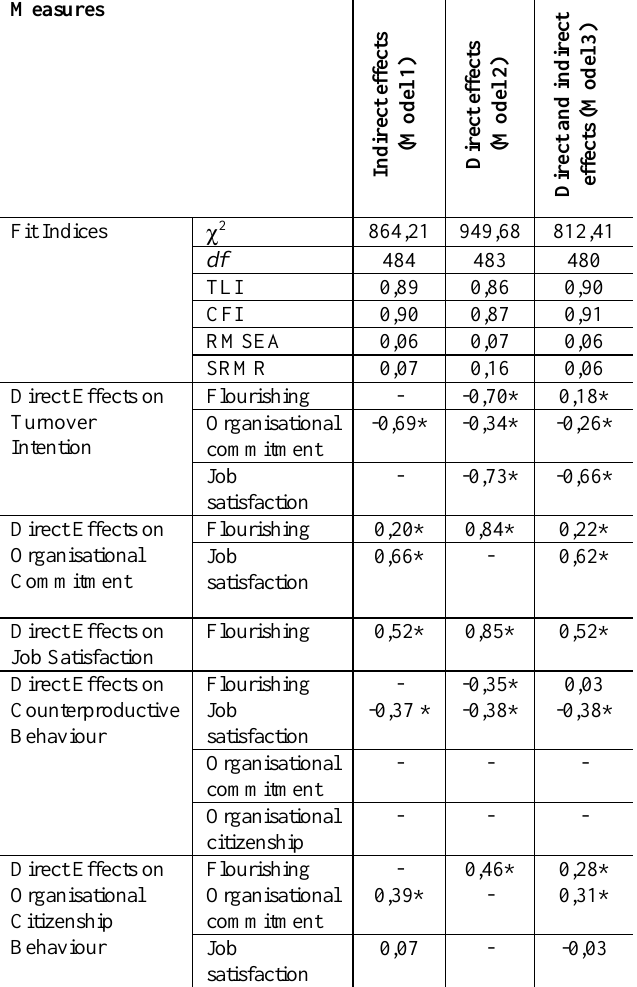
Table 6: Initial framework fit indices and standardized path